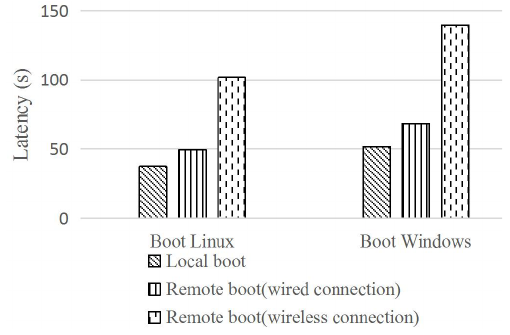
Figure 8. Multi-OS remote booting on-demand in aggregation